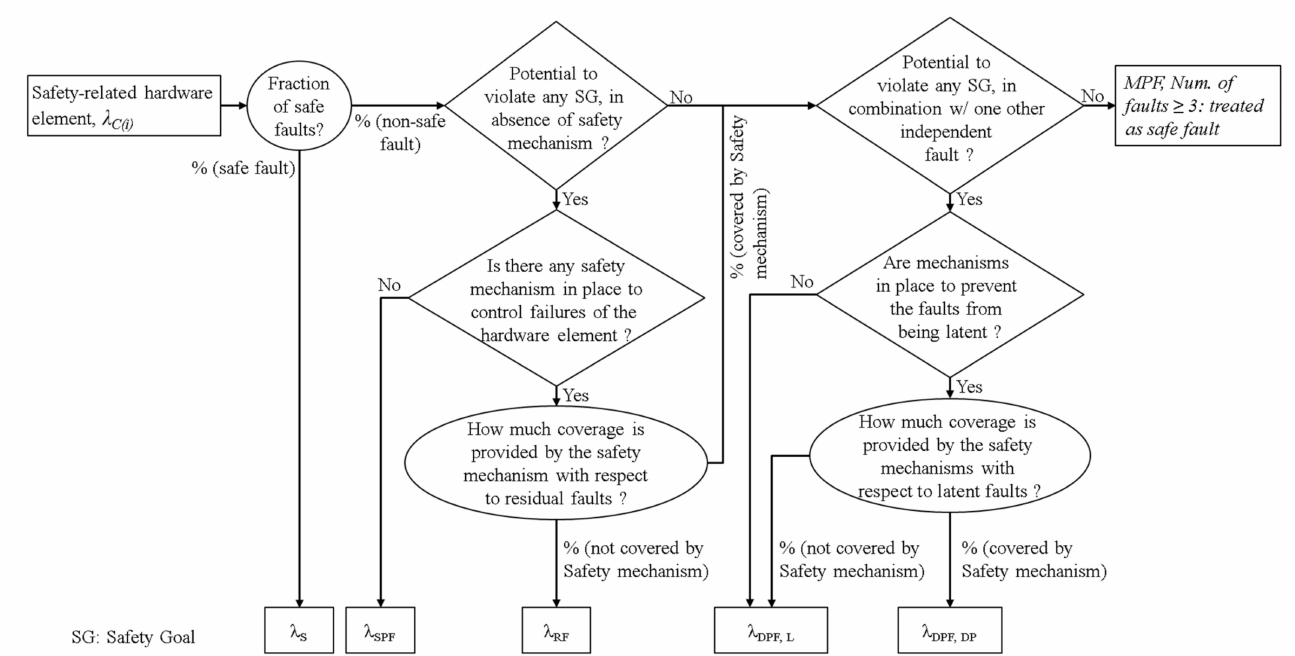
Figure 1. ISO 26262 fault classification and failure rate calculation